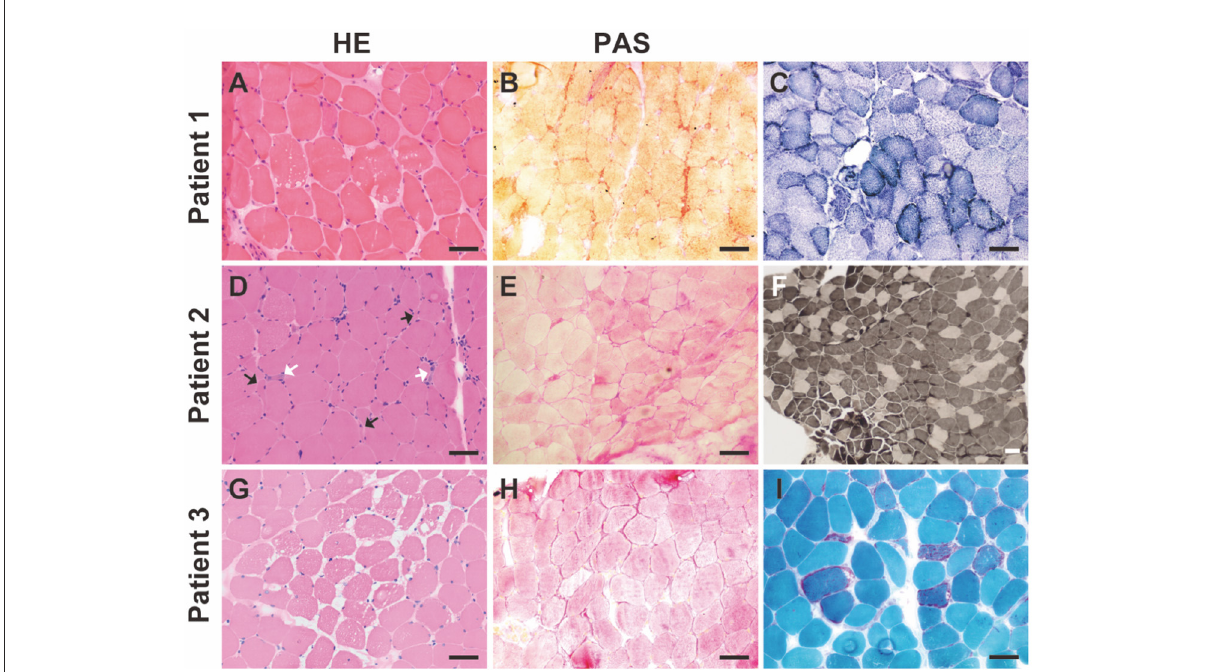
FIGURE1 Myopathological changes in the patients with GSD IXd. (A) Hematoxylin-Eosin (HE) staining shows increased fiber size variation, slight hyperplasia of connective tissue, and vacuoles. (B) Periodic acid-Schiff (PAS) staining shows subsarcolemmal accumulations of glycogen. (C) NADH staining shows slight myofibrillar network disarray and increased subsarcolemmal mitochondria in a subset of myofibers. (D) HE staining shows increased fiber size variation, scattered angular fibers (black arrows), and regenerative fibers (white arrows). (E) PAS staining shows subsarcolemmal accumulations of glycogen. (F) ATPase staining (pH 4.2) shows type I myofiber predominance. (G) HE staining shows increased fiber size variation, slight hyperplasia of connective tissue and vacuoles. (H) PAS staining shows subsarcolemmal accumulations of glycogen. (I) Modified Gömöri staining shows red-ragged fibers. Scale bar = 50 µ m.